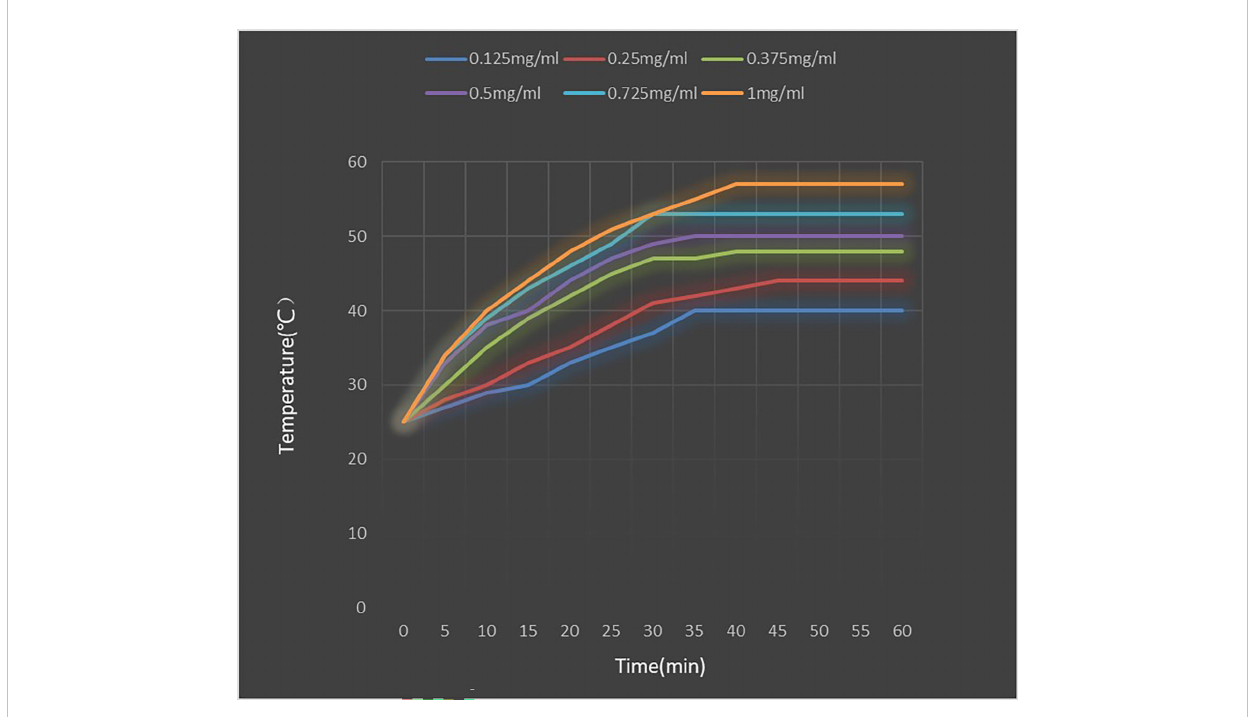
shown in Figure 12. The majority of the nanoparticles were localized in